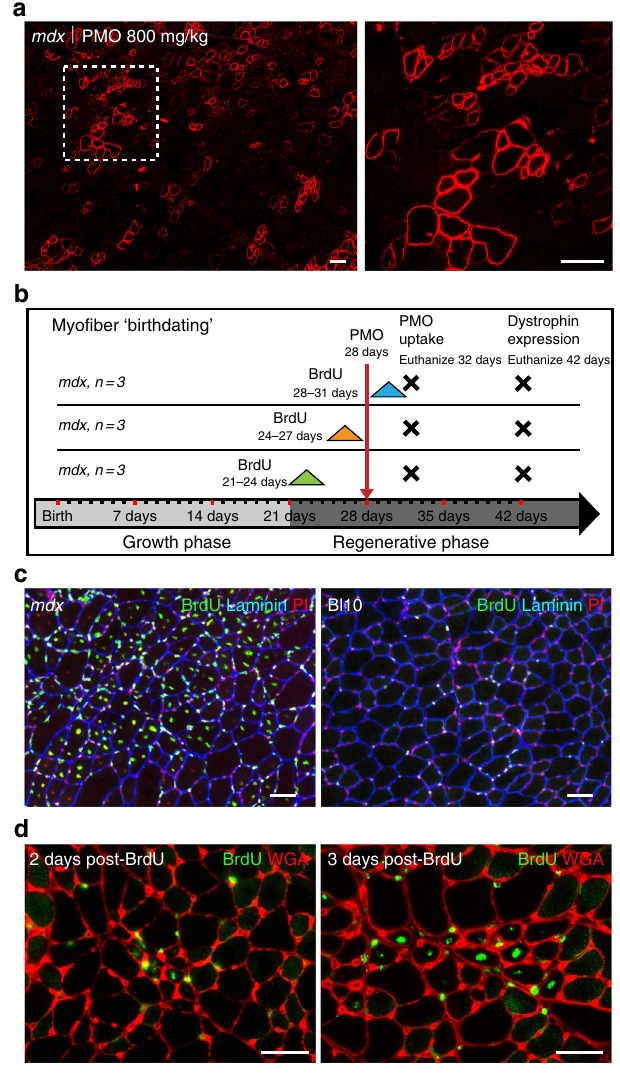
Fig. 1 PMO and BrdU co-administration to investigate PMO uptake and ef fi cacy relative to regeneration. a Patchy dystrophin expression shown in mdx quadriceps 2 weeks after single IV dose of PMO (800 mg/kg, n = 3). Dashed box shows magni fi ed inlay, scale bars represent 100 μ m. b Schematic representation of parallel PMO-BrdU labeling assays to investigate relationship between PMO localization, dystrophin expression, and muscle regeneration. c Onset of mdx pathology at 4 weeks characterized by widespread regeneration shown by BrdU labeling of centrally nucleated fi bers. Bl10 muscle without regeneration shown as control with only minor labeling of interstitial nuclei. BrdU ( green ), laminin ( blue ), and propidium iodide (PI, red ). Scale bars represent 50 μ m. d BrdU labeling of newly regenerated fi bers shown in 4 week mdx gastrocnemius 48 and 72 h following a 24 h feeding of BrdU. Scale bars represent 50 μ